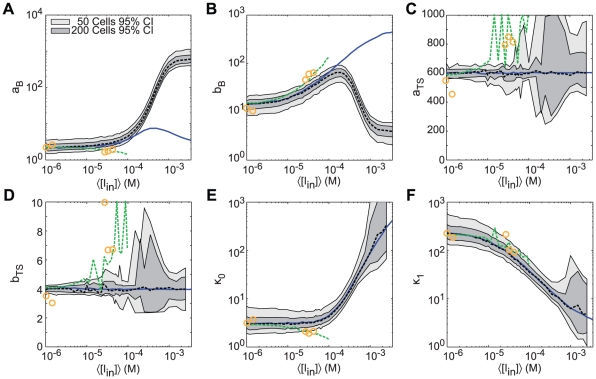
Maximum-likelihood fitting of two models for gene expression to stochastic simulations of an inducible genetic circuit.(A and B) Parameter fits from the burst model. (C–F) Parameter fits from the two-state model. Shown are fits for (black dotted) NPF simulations, (green dotted) PFB simulations, and (orange circles) PFB+IV simulations. Also shown are (blue solid) actual parameter values calculated from the simulation data. Shaded areas indicate the 95% confidence intervals for ML fits using distributions from 50 and 200 NPF cells.